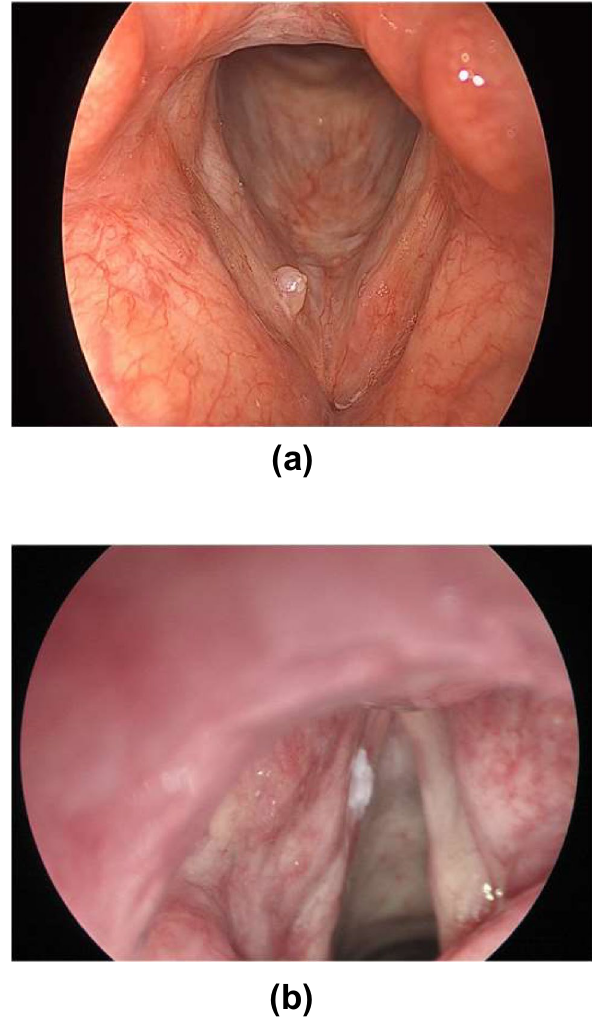
Figure 4. ( a ) and ( b ) are input images that cannot be classified correctly by ResNet18 but can be correctly diagnosed by the proposed HDCNet.